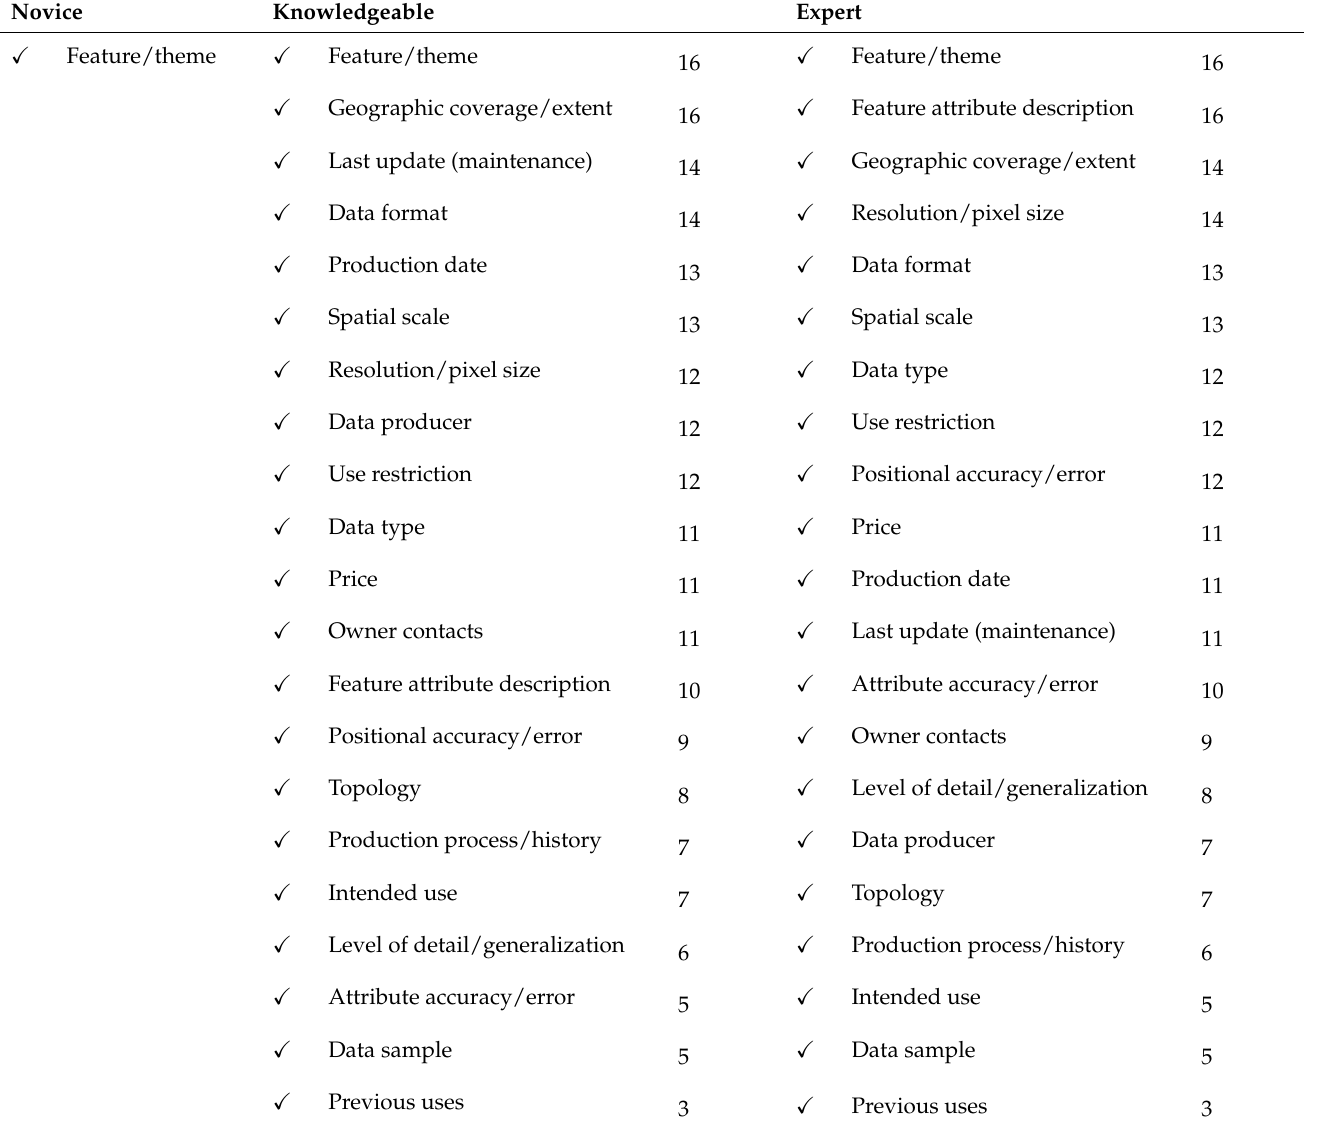
Table 14. Information required by participants for spatial data